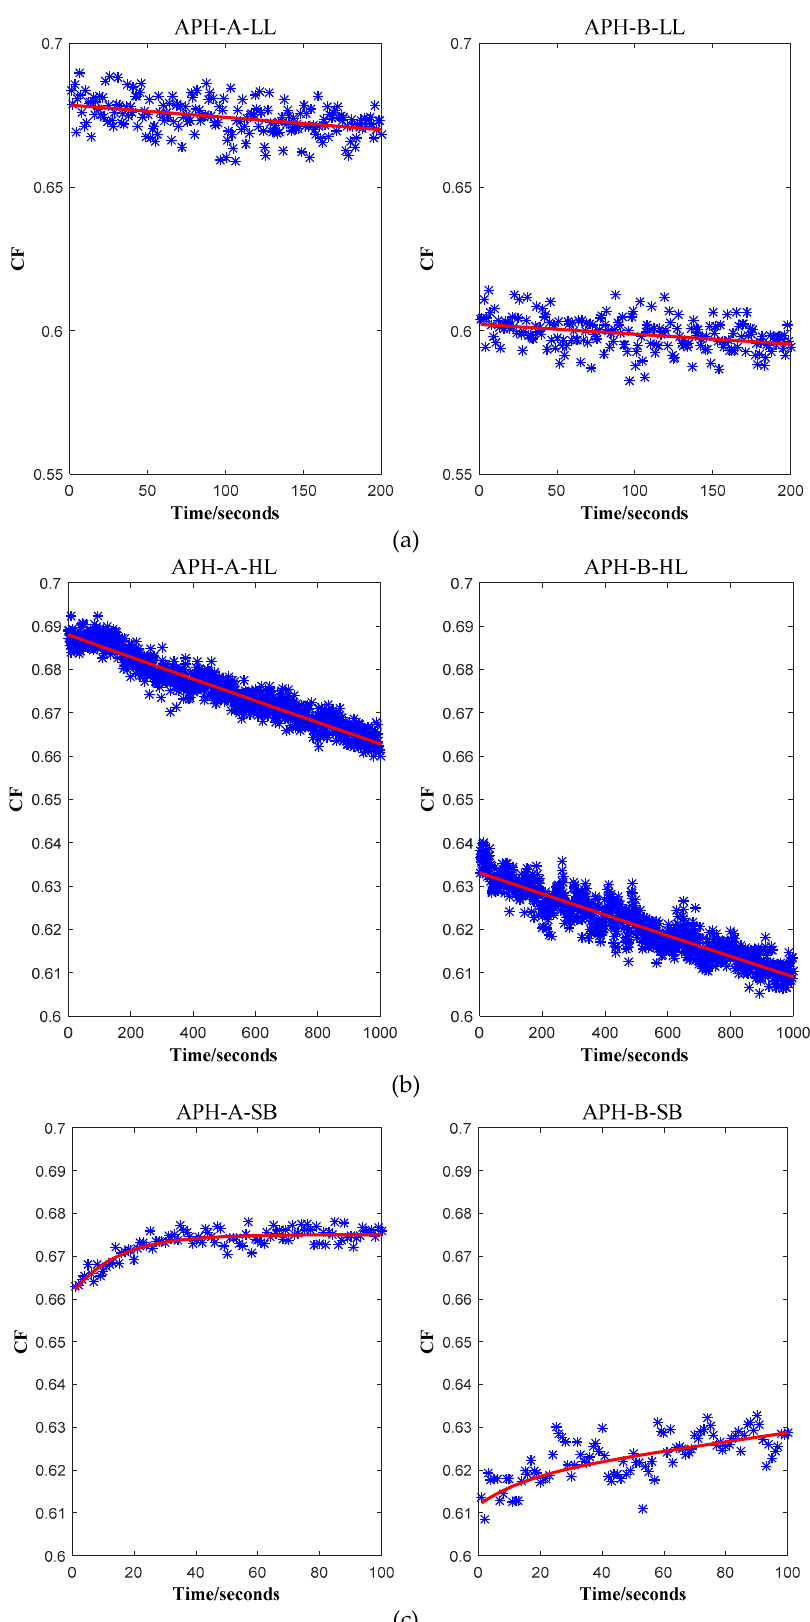
Figure 5. CF curves and fitting models in different cases: ( a ) LL, ( b ) HL, and ( c ) SB.